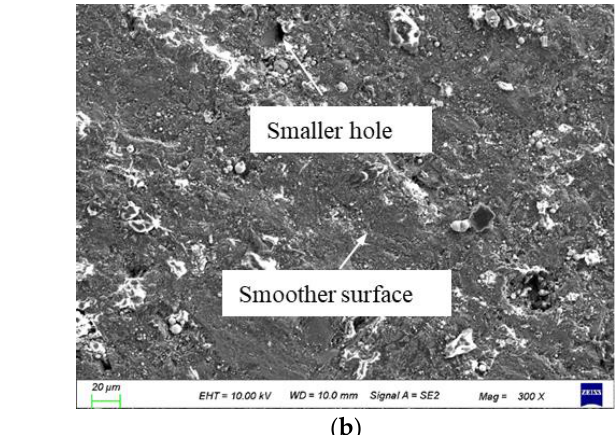
10 of 15 ( b ) Figure 10. The effect of different amplitudes on surface roughness: ( a ) amplitude of workpiece and ( b ) amplitude of tool. The SEM images of the machined surface at different amplitudes are shown in Figure 11. Compared with the amplitude of 3 μm, when the amplitude is 5 μm, the protrusion height significantly reduces, the SiC particles that are exposed on the surface are rolled and pushed, the bottom of the pit is rolled and smoothed, the number of holes reduces,